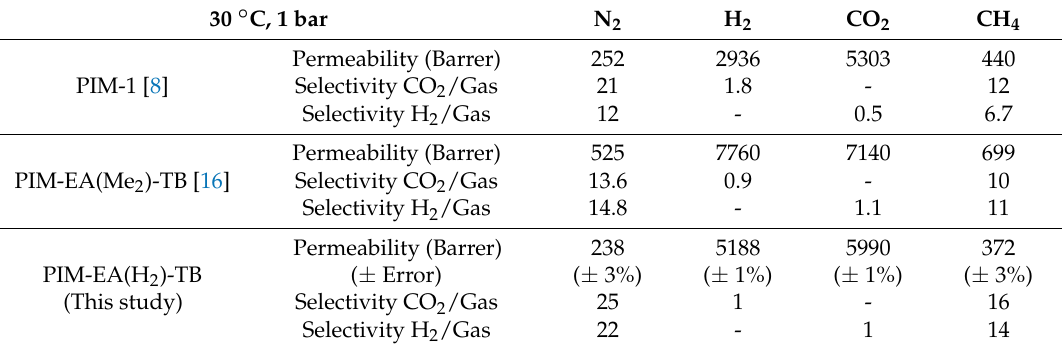
Table 2. Gas permeabilities and ideal selectivities (CO 2 /Gas, H 2 /Gas) for MeOH treated film PIM-EA(H 2 )-TB at 30 ◦ C, 1 bar (Errors calculated by statistical analysis of repeated measurements from separately prepared films (between 3 and